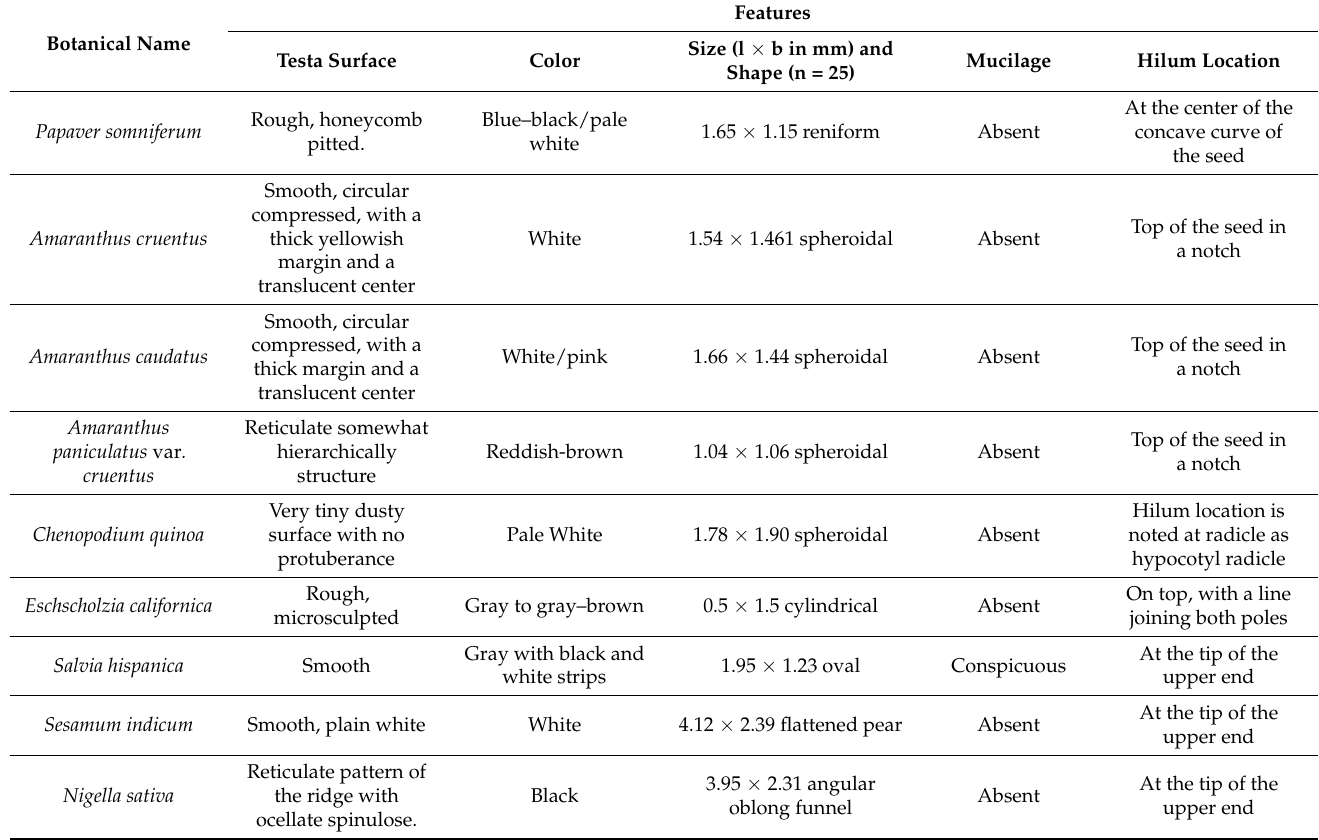
Table 1. List of salient features to distinguish the poppy seeds from their